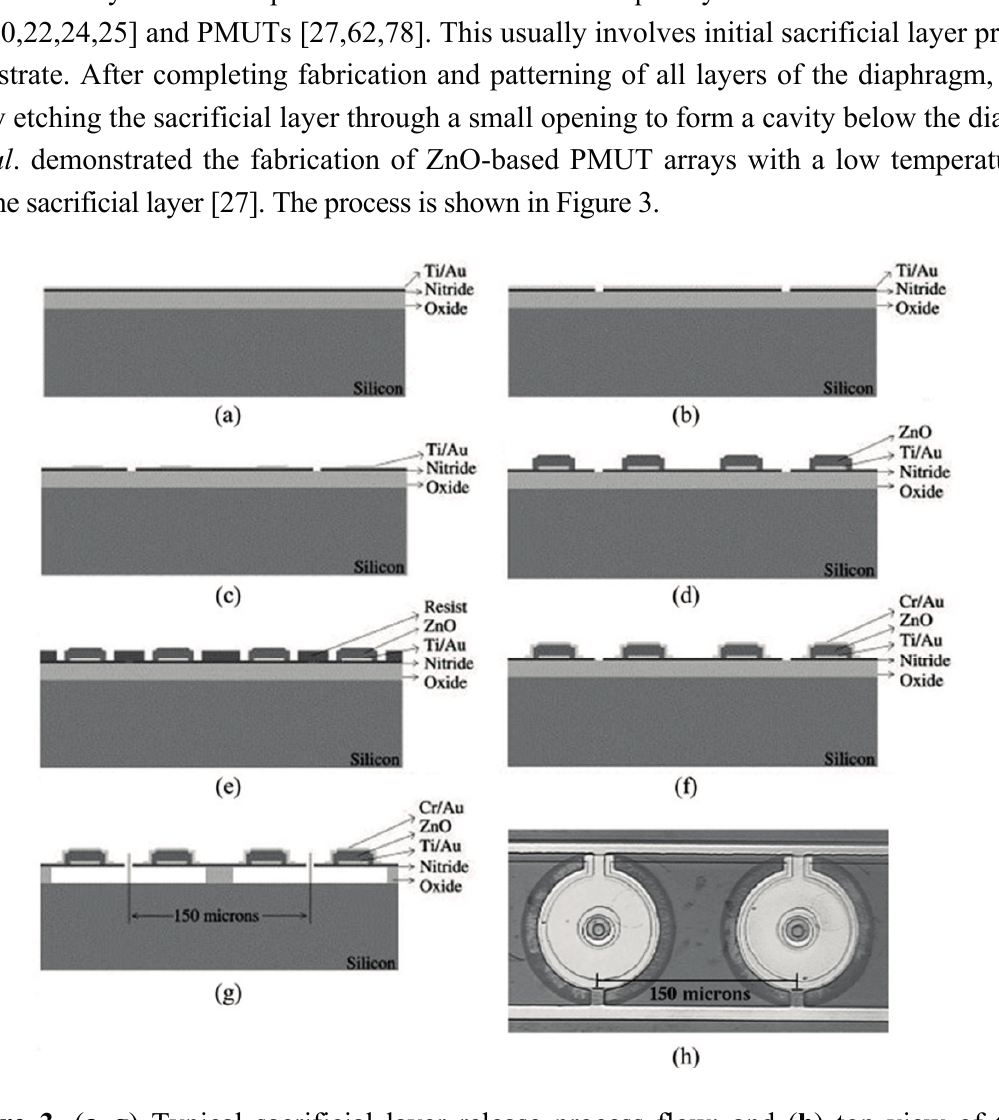
Figure 3. ( a – g ) Typical sacrificial layer release process flow; and ( h ) top view of two fabricated adjacent PMUT elements. © 1998 AIP Publishing LLC. Reprinted with permission from